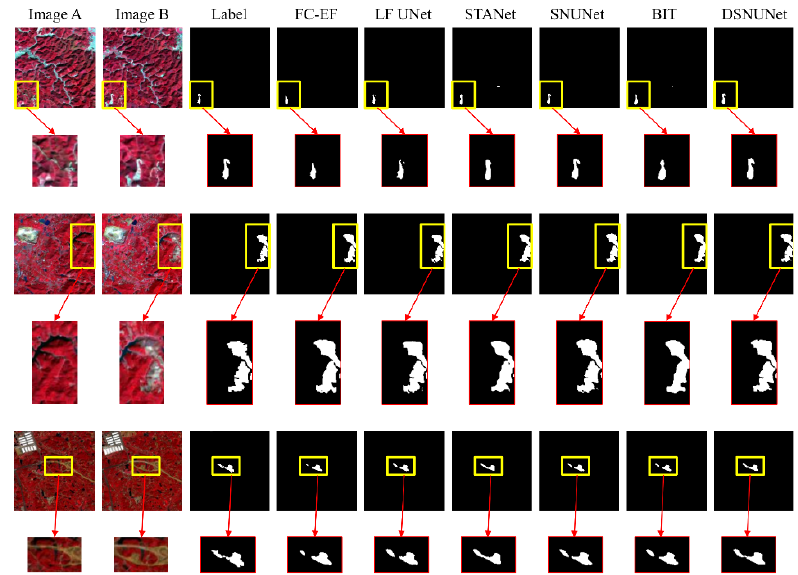
Figure 8. Prediction results of DSNUNet and other models based on SAR images added to the input.